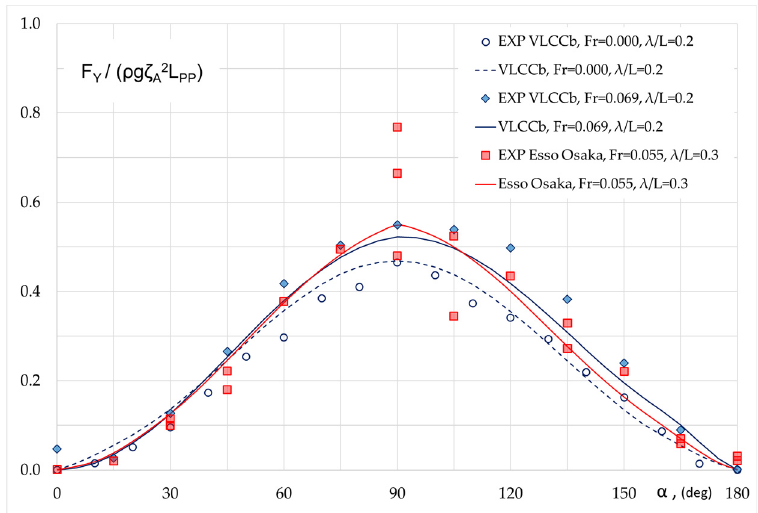
Figure 14. Prediction of the mean sway force by proposed empirical formula for two full type ships in regular waves at low speeds.